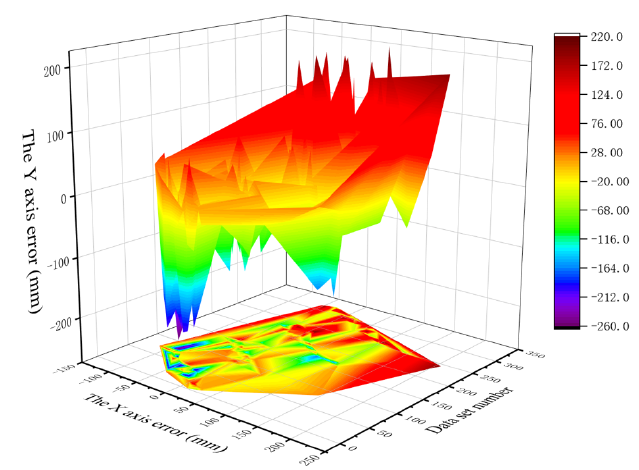
Figure 11. 2D ( X , Y ) accuracy of abnormal data sets based on C-T-CNN-SVM